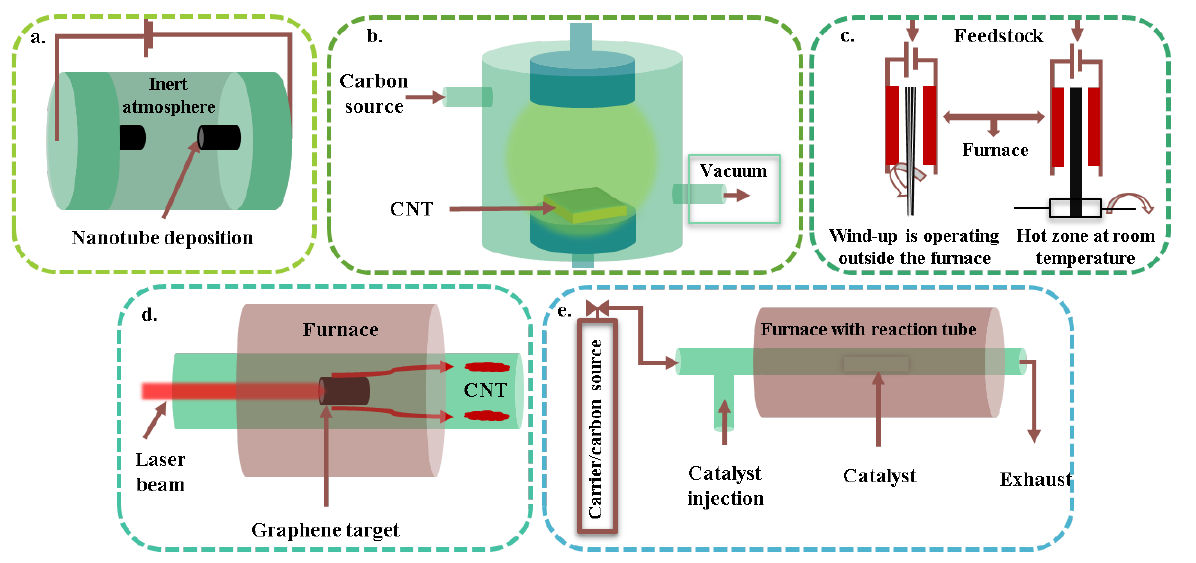
Figure 12. Various schematics for CNT fabrication techniques: ( a ) arc discharge apparatus, ( b ) parallel plate PECVD system, ( c ) direct aerosol spinning process, ( d ) laser ablation method, ( e ) thermal CVD system with a tube furnace.